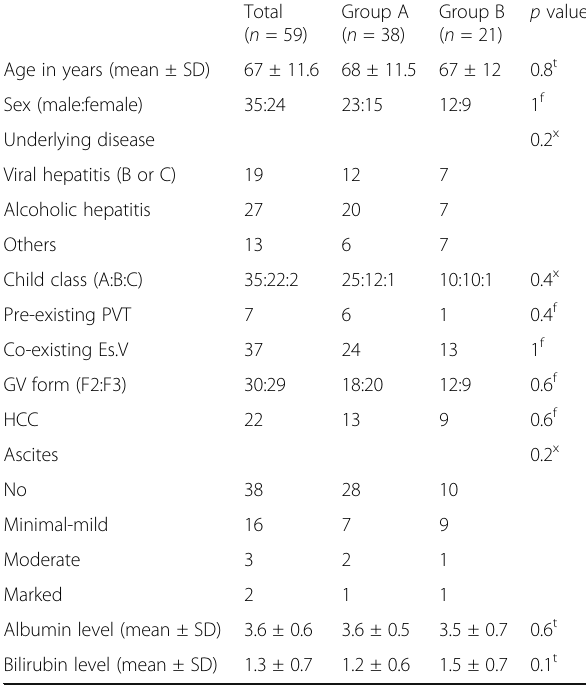
Table 1 Demographic data of total 59 patients